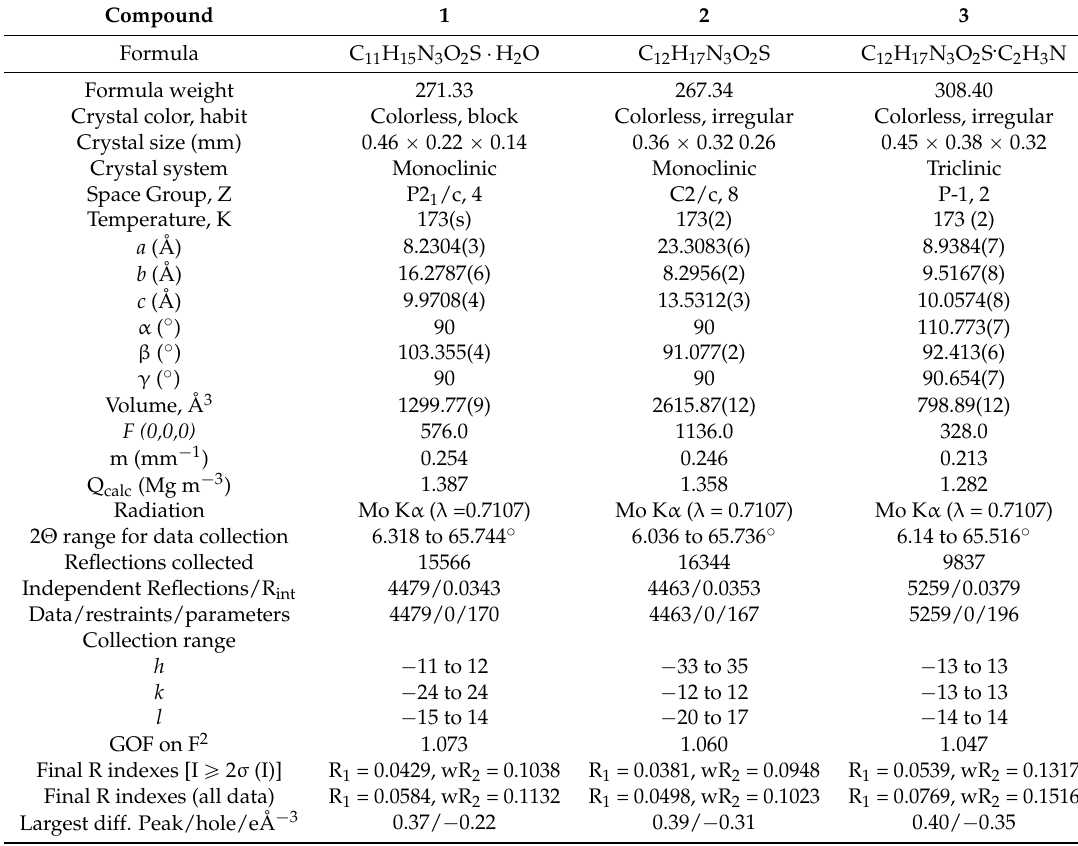
Table 10. Crystal and experimental data for ( 1 ), ( 2 ) and ( 3